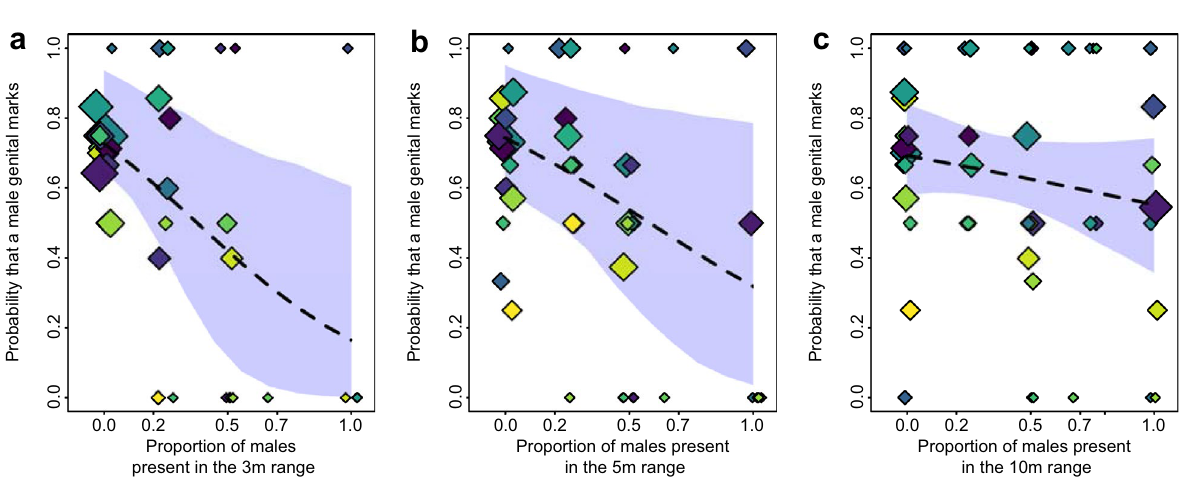
Figure 1. Probability that a male deposited a scent mark depending on the proportion of males present ( a ) in a 3 m radius, ( b ) in a 5 m radius, ( c ) in a 10 m radius. Colours correspond to the different individuals (n = 14), and the size of the circle corresponds to the number of observations (in total, n = 165). This figure was visualized and edited using R (https:// www.r- proje ct.